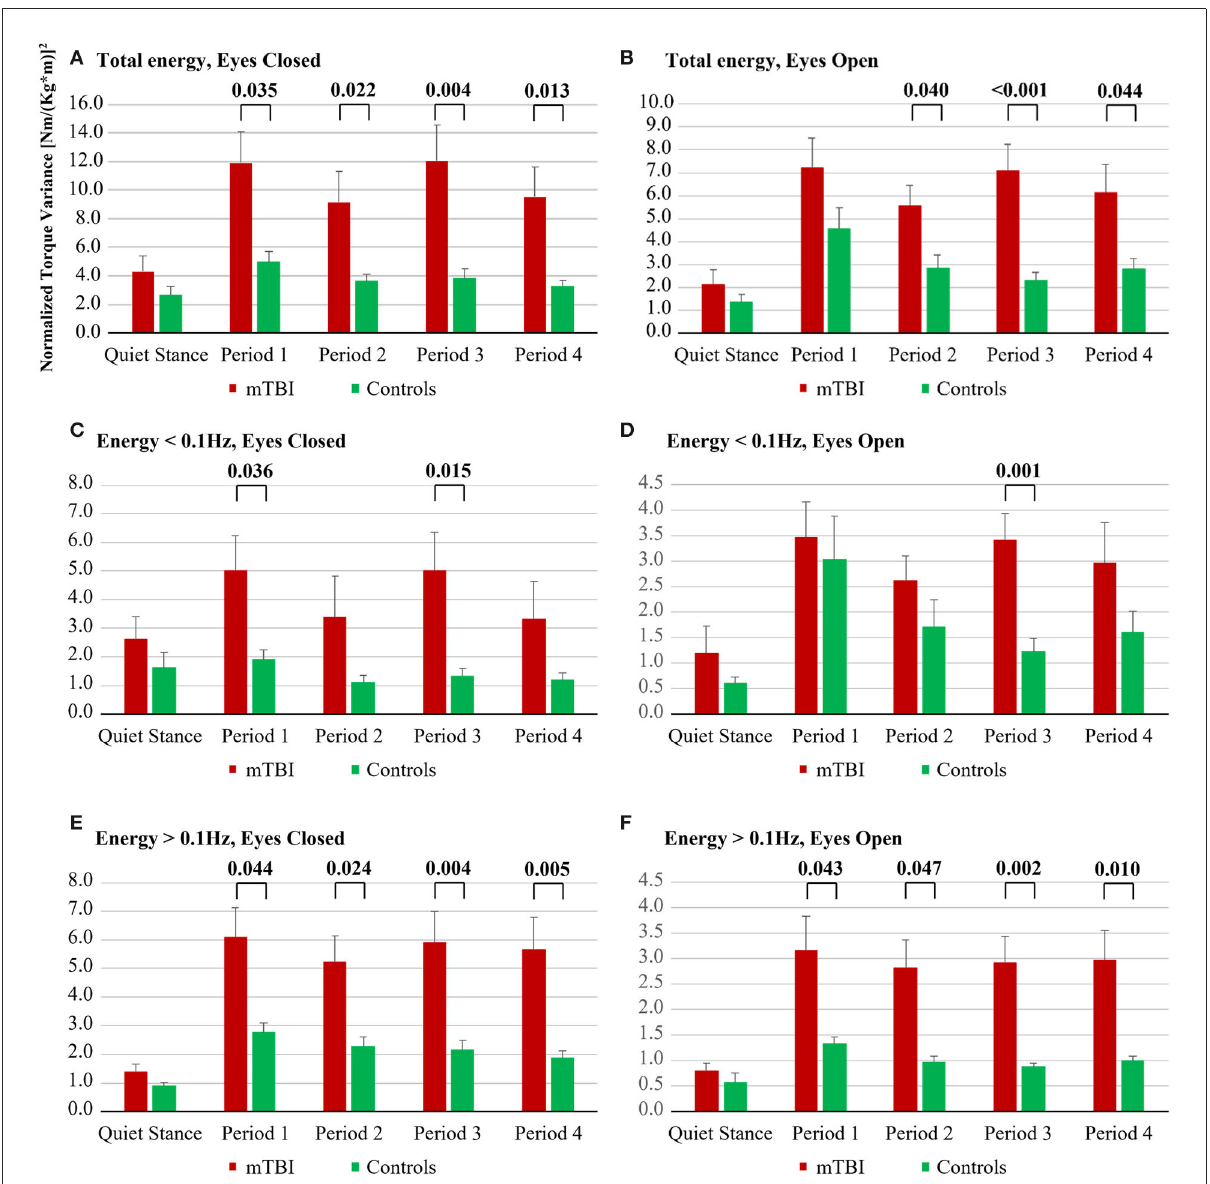
FIGURE1 Energy used by mTBI subjects and by controls during the five balance perturbation periods; (A) Total energy, Eyes Closed; (B) Total energy, Eyes Open; (C) Energy < 0.1Hz, Eyes Closed; (D) Energy < 0.1Hz, Eyes Open; (E) Energy > 0.1Hz, Eyes Closed; (F) Energy > 0.1Hz, Eyes